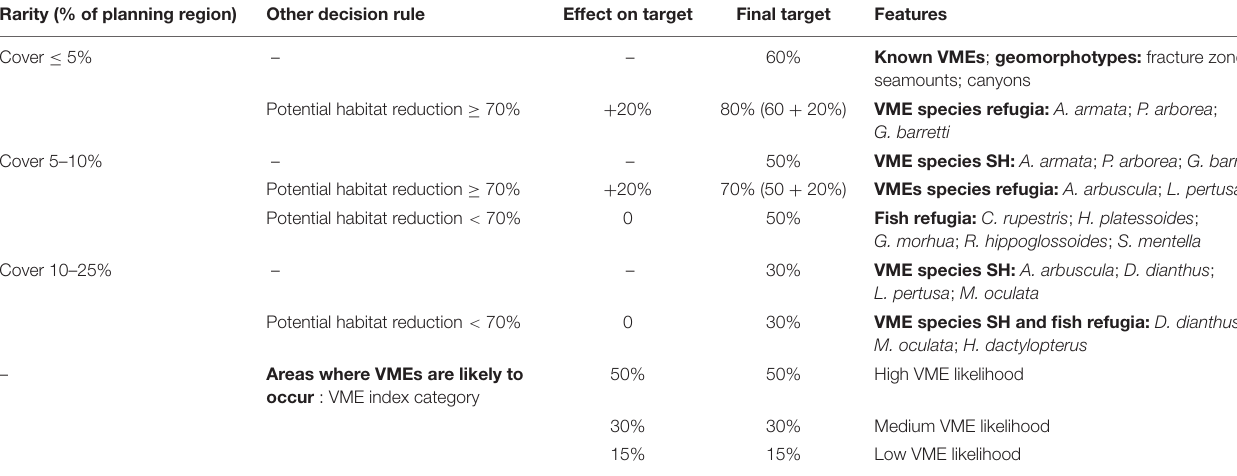
TABLE 1 | Summary of conservation target attribution for each conservation feature. Rarity (% of planning region)